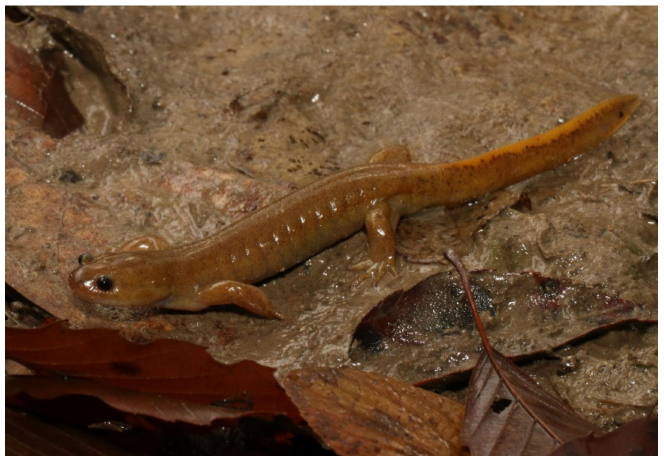
Figure 5. Live holotype of Hynobius kunibiki sp. nov. (TRPM-ARA-0000014, adult